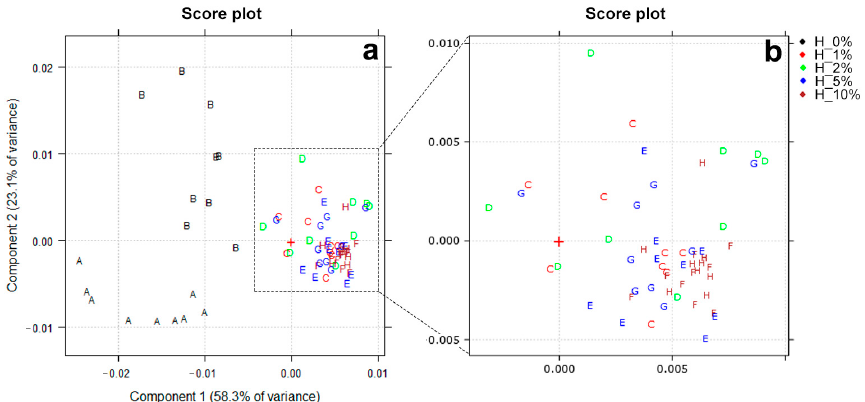
Figure 6. Results of the principal component analysis (PCA) performed on the reflection FT-IR spectral dataset in the range 1400–400 cm − 1 : PC1 versus PC2 scatter score plot ( a ) and its magnification in correspondence of the region enclosed in the dotted rectangle ( b ). Letters indicate the mock-ups under investigation; colors highlight different hematite concentrations in the paint layer as reported in the legend (i.e., H_0%, H_1%, H_2%, H_5%, and H_10%, where the letter H stands for hematite).